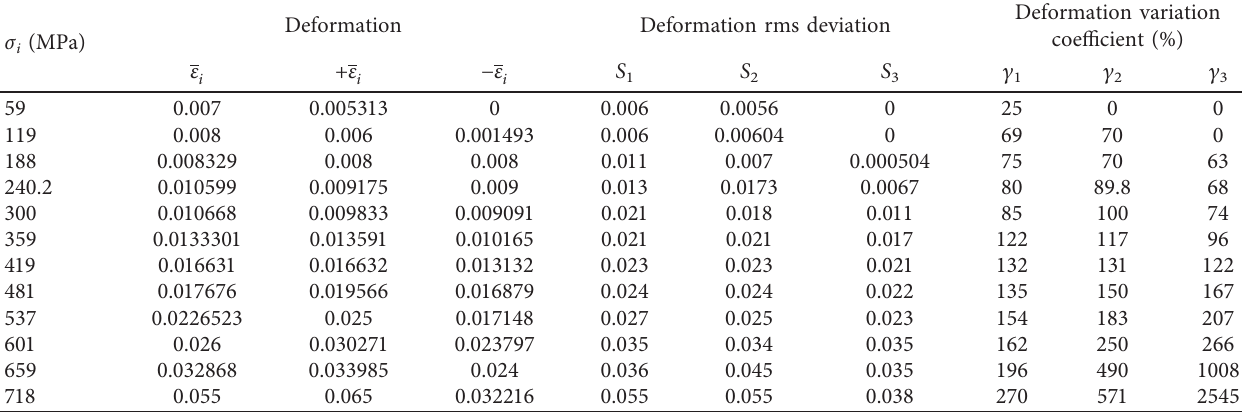
Table 7: Experimental data characterizing the microplastic deformation of the deposited samples of steel 530H40 after heat treatment according to mode II (group II).